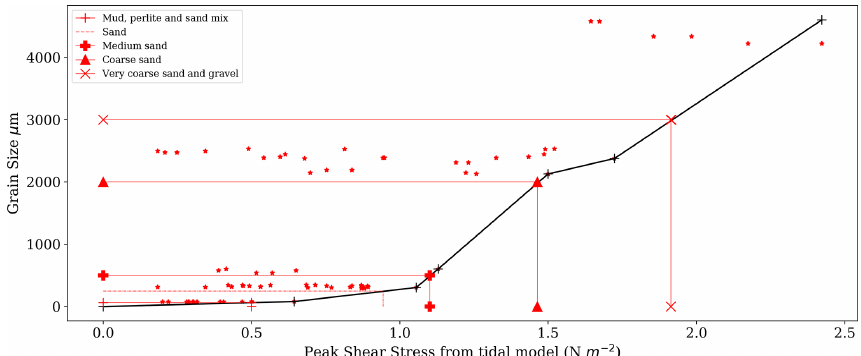
Figure 6. Median d 50 grain size values from Betzler et al. (2016) and associated peak shear stress values from the simulation. A line is fit through the maximum peak shear stress values derived from the simulation, with corresponding peak shear stress values for the grain size classes obtained (provided in Table